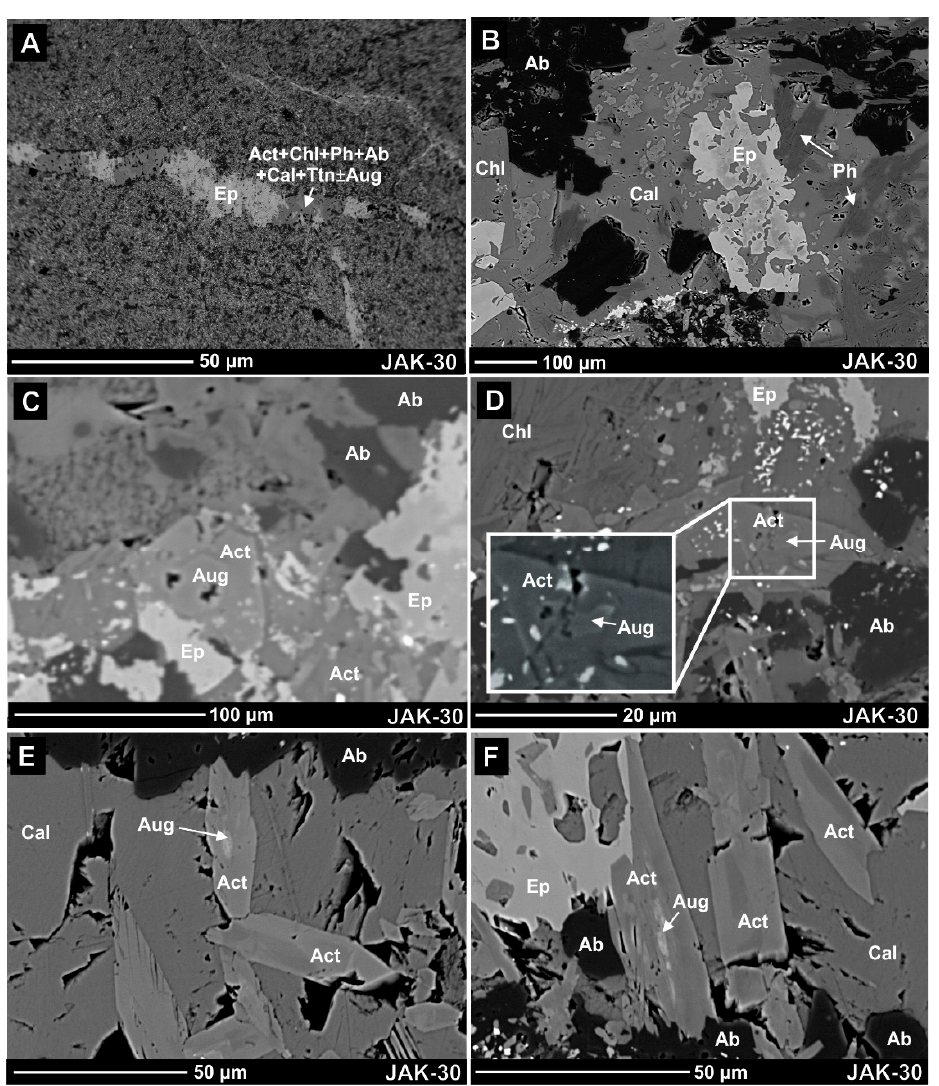
Figure 14. BSE images of the relic magmatic Aug in the metamorphic veins of metabasalt sample JAK-30 in the Jaklovce Unit: ( A ) fine-grained (meta)basalt crosscut by metamorphic veinlet composed of Chl, Act, Ep, Ab, Cal with relics of Aug; ( B ) detail of the Chl, Ep, Ab, Cal and Ph metamorphic veinlet; ( C , D ) relics of magmatic Aug overgrown by Act in a metamorphic veinlet; ( E , F ) irregular relics of Aug in metamorphic